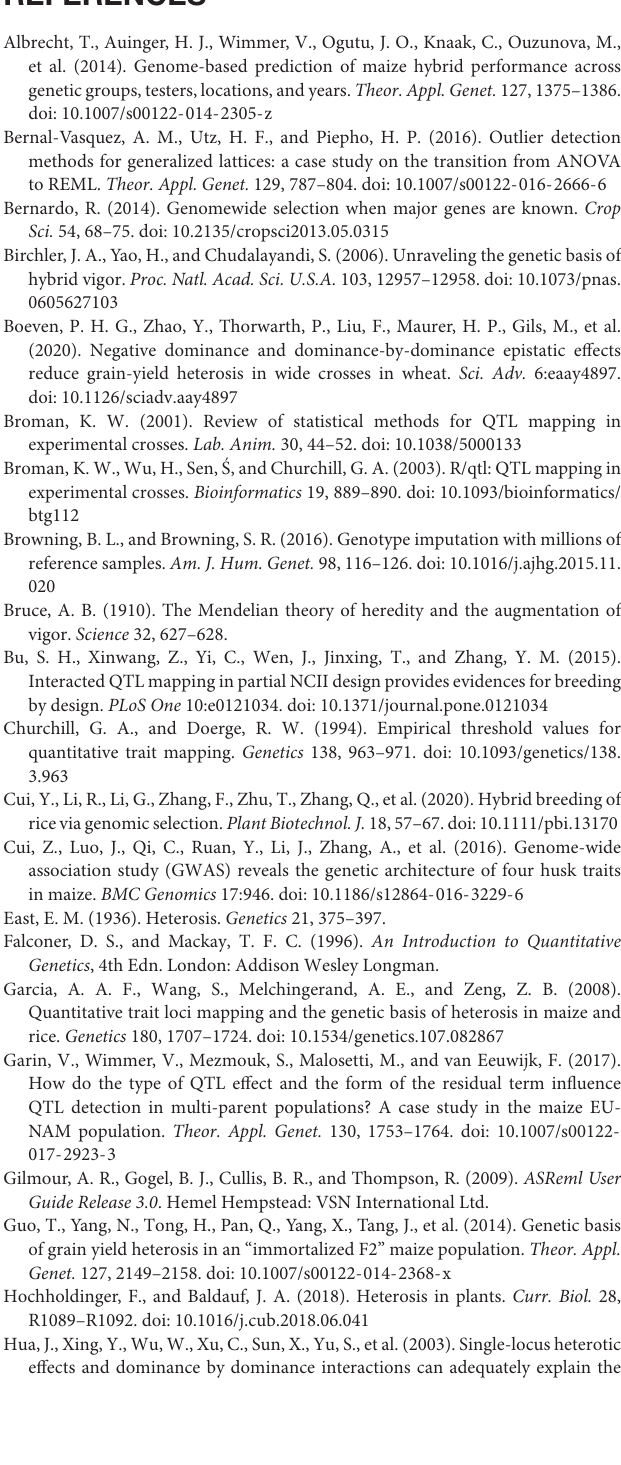
Supplementary Table 8 | Significant epistatic paired loci for 10 traits identified from the pooled Chang7-2 × RIL (TC)-Mo17 × RIL (TM) population. Supplementary Table 9 | Correlations between the number of harbored favorable quantitative trait loci (QTL) and hybrid performance for 10 traits